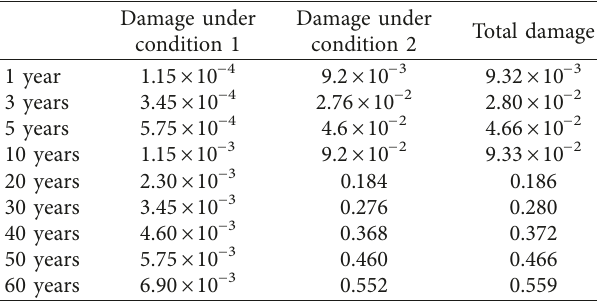
Table 10: Damage of the self-compacting concrete layer under temperature load after different service